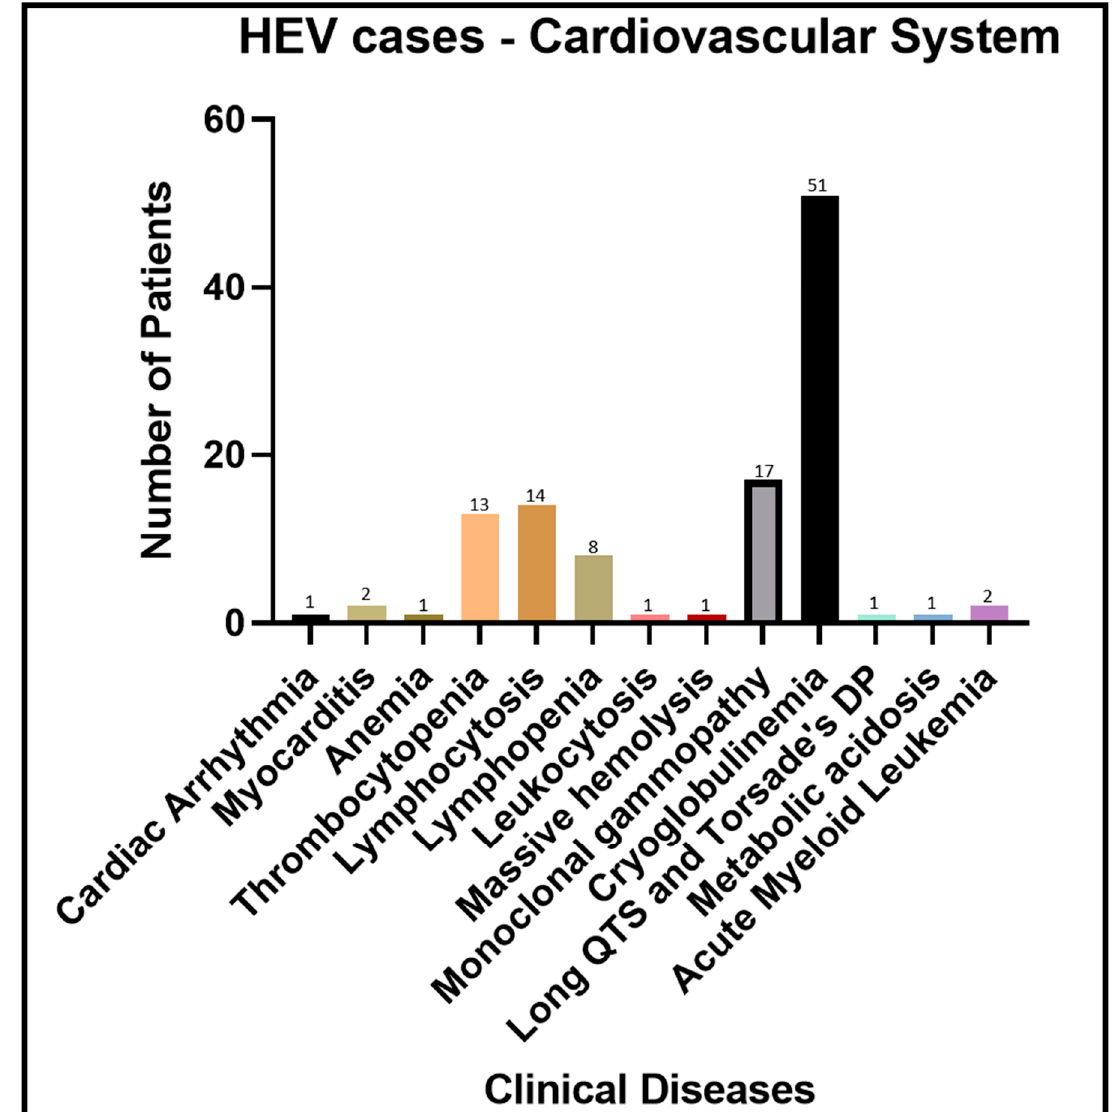
Figure 2. Summary of the cardiovascular clinical disorders presented in relation to HEV infection. The numbers are isolated from case reports, retrospective studies, case-control studies, case series, and cross-sectional studies. Every reported disorder and their references are listed in Table 2.